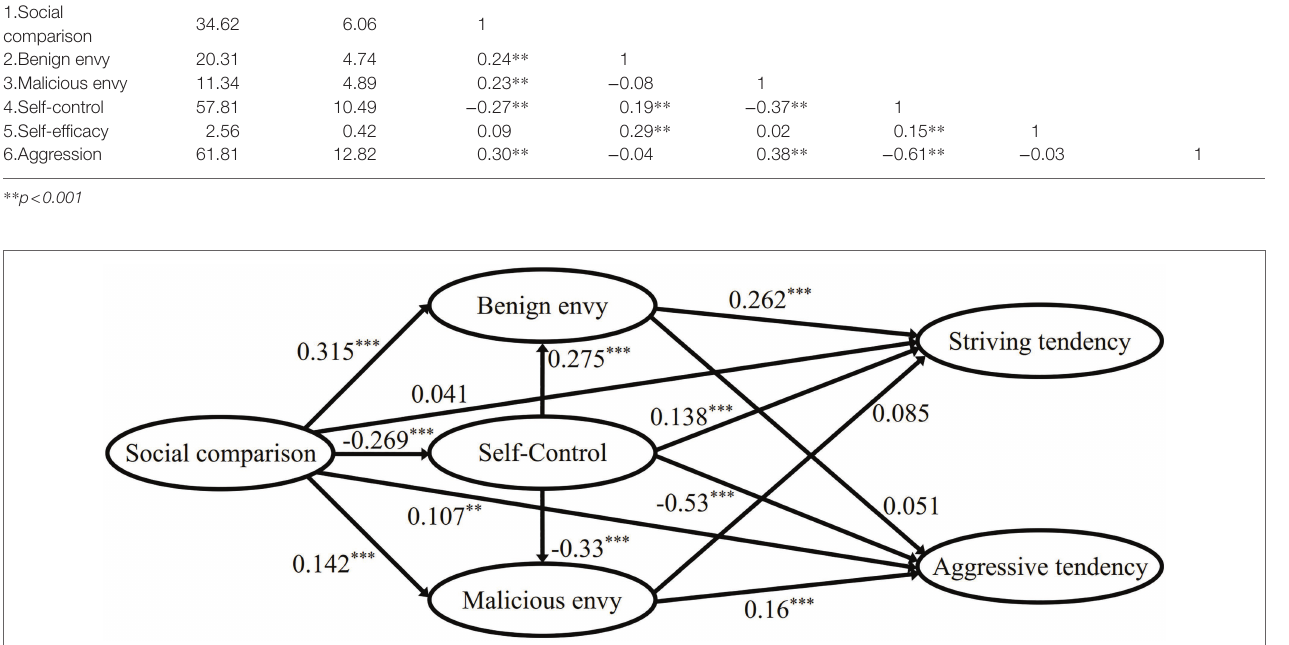
FIGURE 1 | Behavior result of envy path analysis parameter estimation result (saturation model). Note: Self-efficacy was used as a measure of striving tendency on the trait level. ** p < 0.01, *** p <